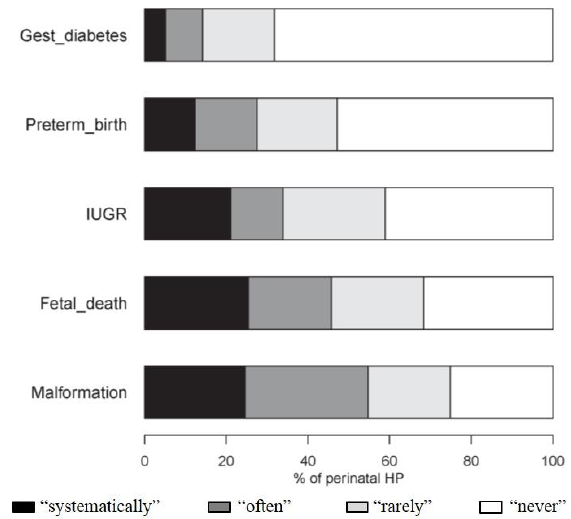
Figure 5. Investigation for exposure to environmental contaminants (except tobacco, alcohol and drugs) in the event of obstetric disorders. Gest_diabetes, gestational diabetes; HP, health professionals; IUGR, intrauterine growth restriction.